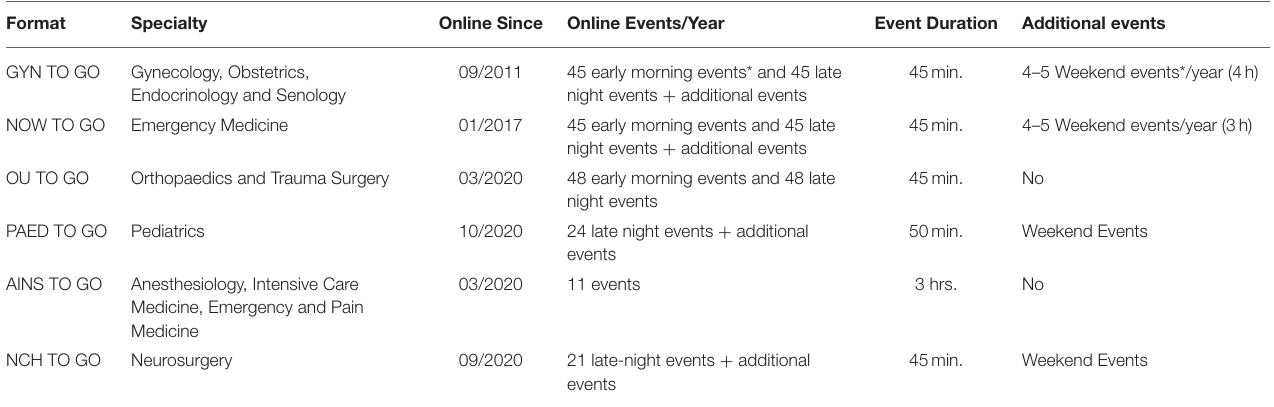
TABLE 1 | Online continuing medical education on MEDIZIN TO GO (November